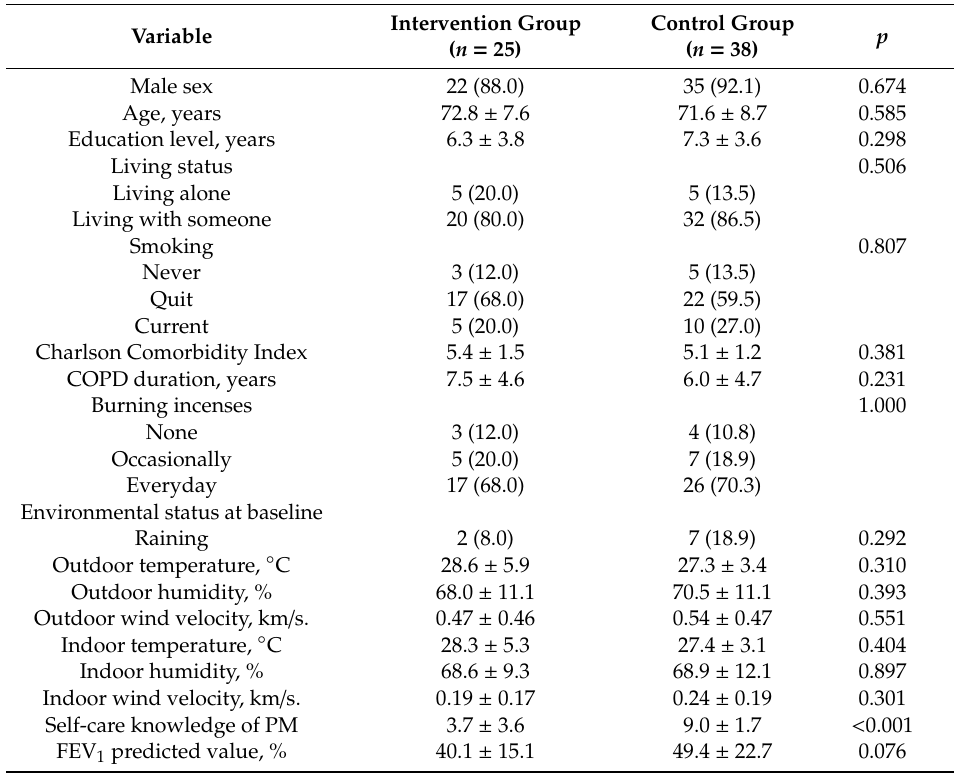
Table 1. Baseline demographic and clinical characteristics of patients in the intervention and control groups ( n =